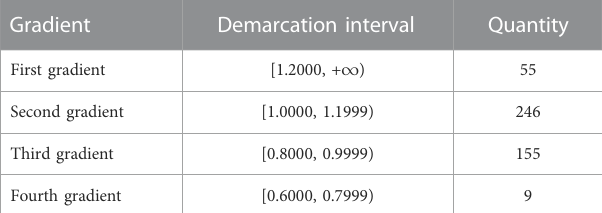
TABLE 2 Green development quality gradient distribution table of the construction